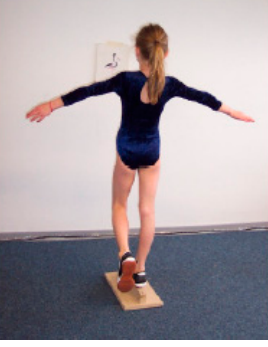
Figure 4. Test setup ‘One-leg stand’, ©Testmanual KiMo-Test; Dr. rer. Nat. S. Dordel, Dr. sports